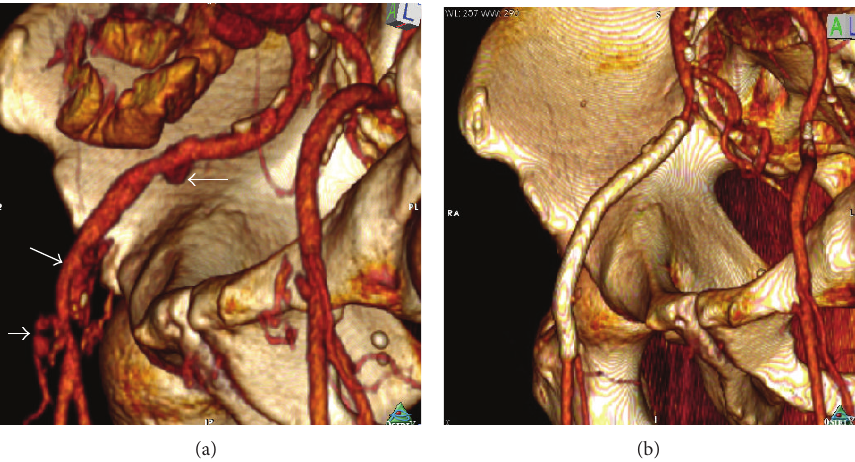
Figure 1: (a) Preoperative computed tomography angiography (CTA) reconstruction, showing the 3 saccular aneurysms of the right external iliac artery (arrows); (b) CTA reconstruction at 3-month followup. In total, two covered stents were deployed with successful exclusion of the infected aneurysms.